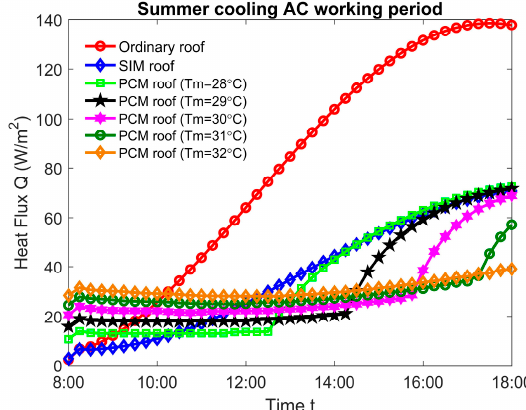
Figure 3. Iteration process of the roof temperature during the computation.